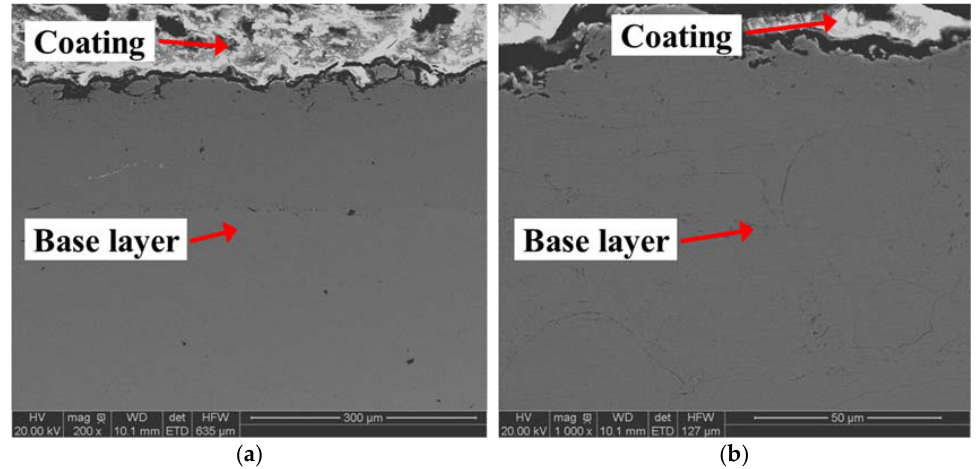
Figure 3. HVOF-coated plate cross-section morphology: ( a ) 200 times, ( b ) 1000 times.